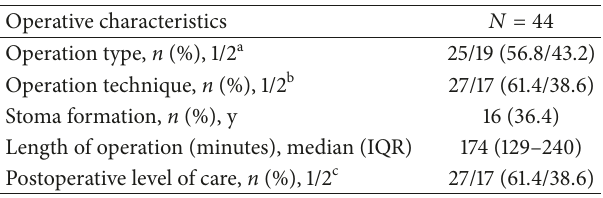
Table 2: Operative